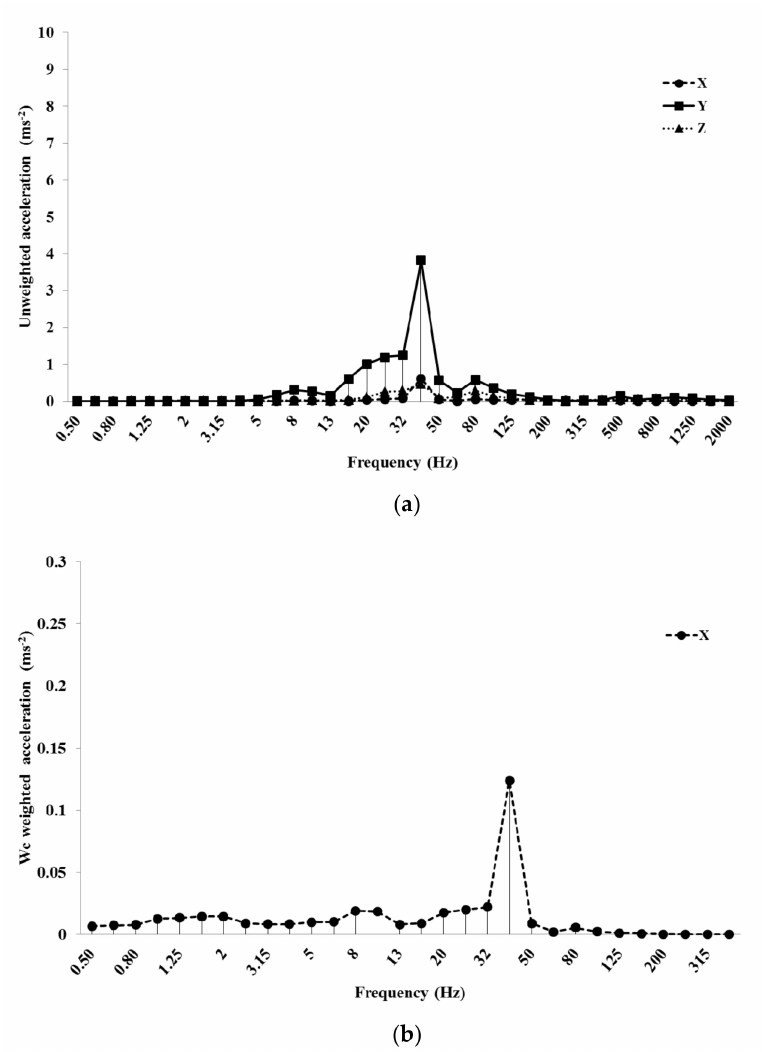
Figure 6. Unweighted ( a ) and W c weighted frequency analysis ( b ) of the acceleration values of blower #1 at LES (low engine